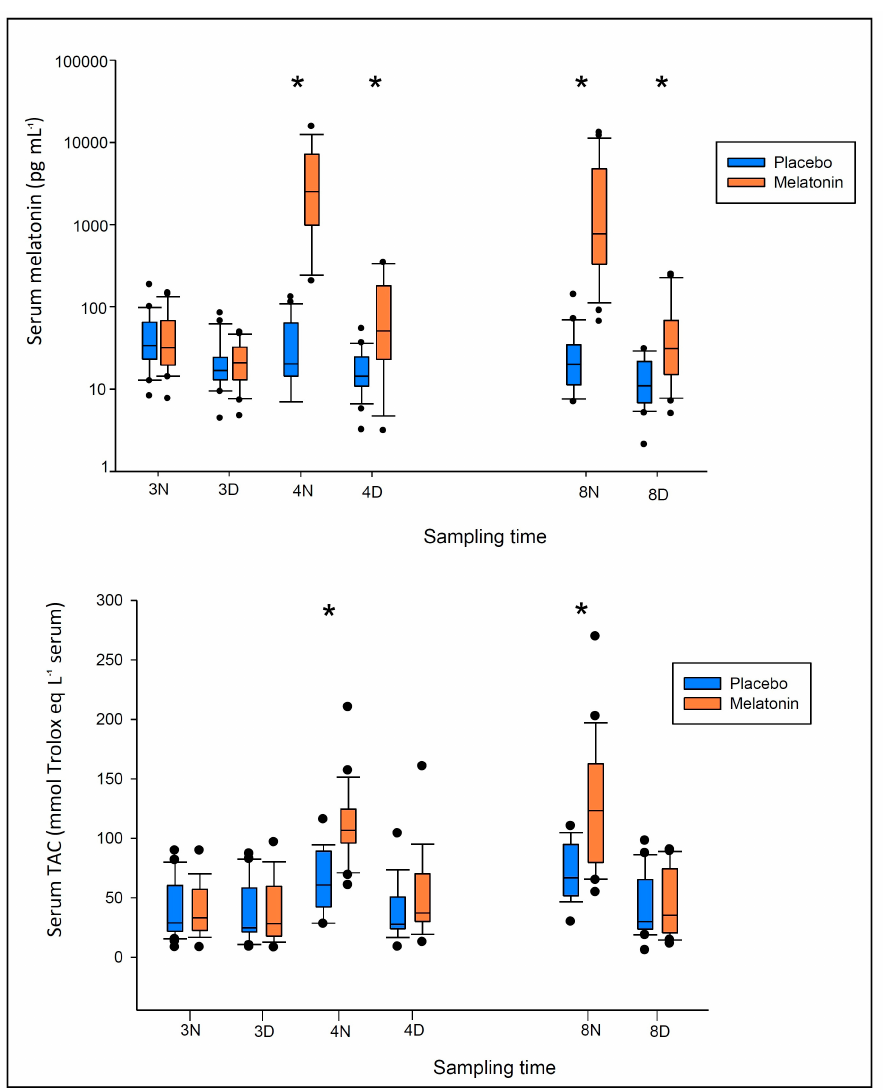
Figure 3. Serum melatonin and total antioxidant capacity (TAC) values measured in critically-ill patients at midnight (N) and at 14:00 h (D) of the 3rd, 4th, and 8th ICU day. Patients were randomized to receive either melatonin 3 mg at 20:00 h and midnight or placebo from the 4th ICU day. Data are represented as “box and whiskers” plots: within each plot, the box is bordered at the first (Q1) and third (Q3) quartile of the variable, and is cut by a line corresponding to the median; whiskers extend from the box to the 95% confidence interval. Dots represent outlier values. Comparisons were made by Wilcoxon rank-sum test for unmatched data. * denotes p < 0.05 between groups.